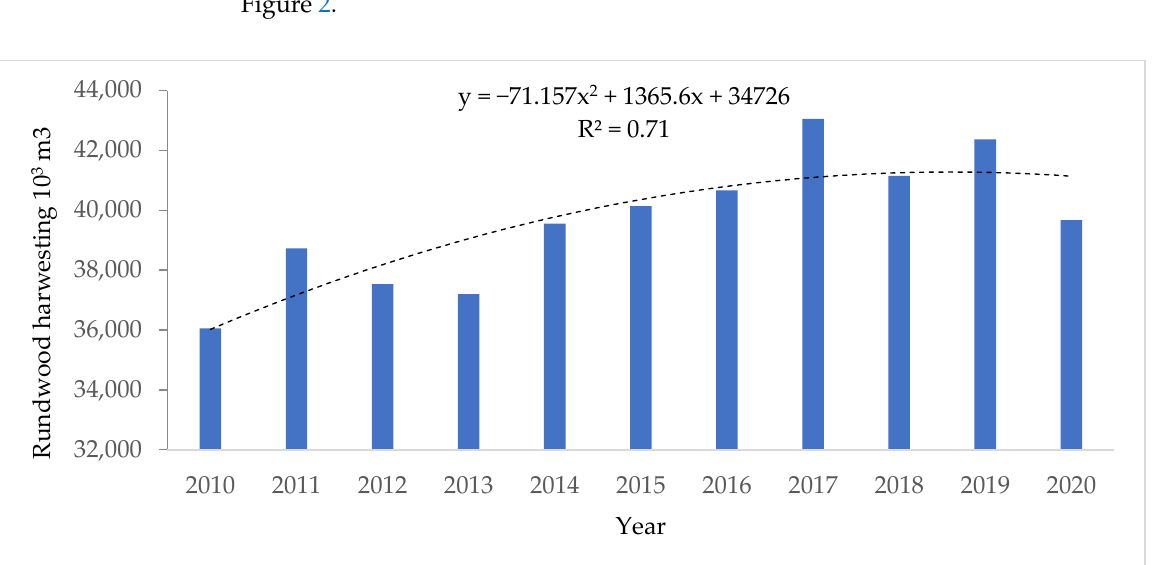
Type of Production